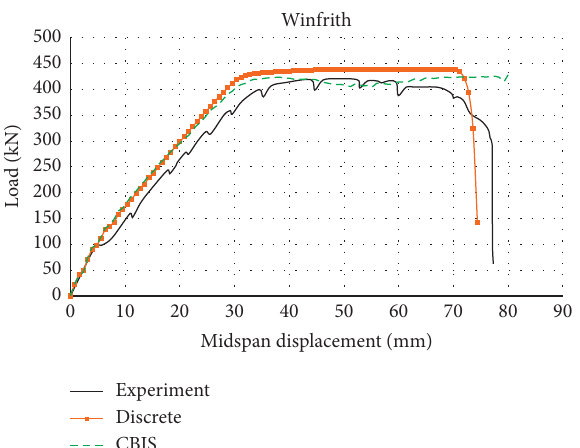
Figure 13: Comparison of the discrete model and CBIS model when Winfrith concrete material option is used.